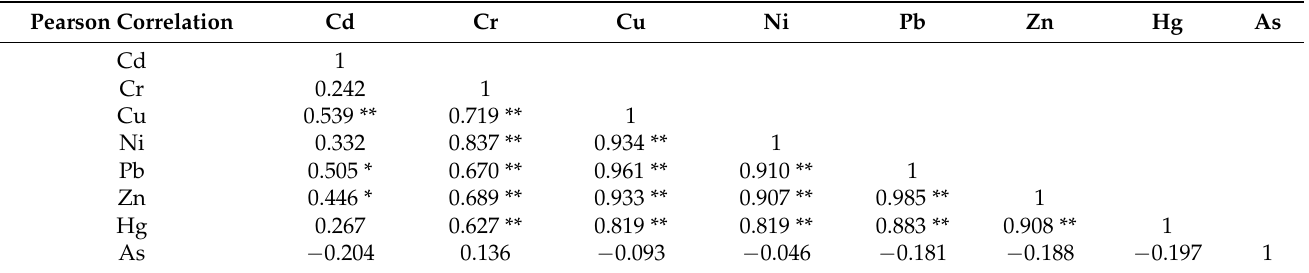
Table 7. The correlation coefficients between heavy metals in sediments of the Huafei River.